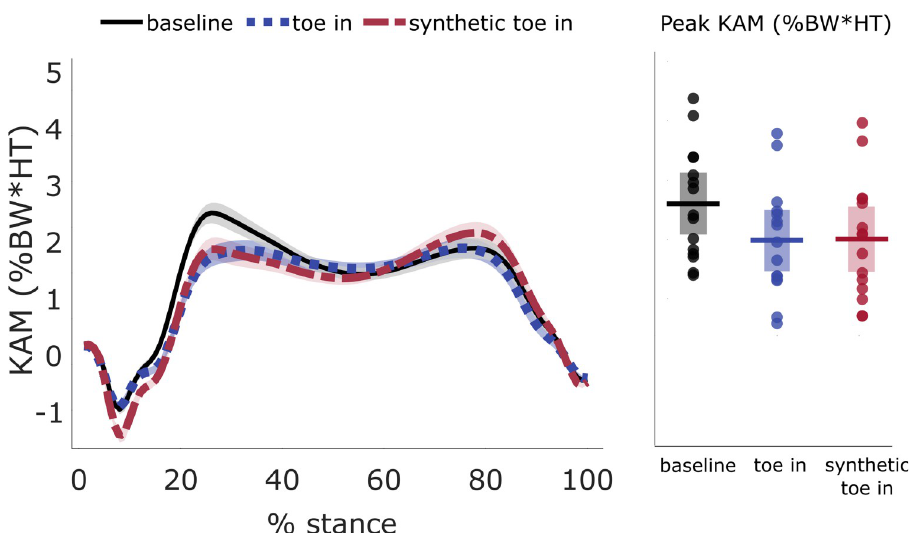
Fig 6. Validation of synthetic toe-in KAM (Carnegie Mellon University dataset). The synthetic toe-in KAM trajectory (red, dashed line) closely matched the real toe-in KAM (blue, dotted line). Synthetic KAM captured the within-subject reduction in the first peak of KAM, relative to baseline (black, solid line) with an MAE of 0.170% BW � HT. The left plot captures mean ( ± STD) KAM trajectories across subjects, while the right plot shows individual and mean peak KAM with 95% confidence intervals.